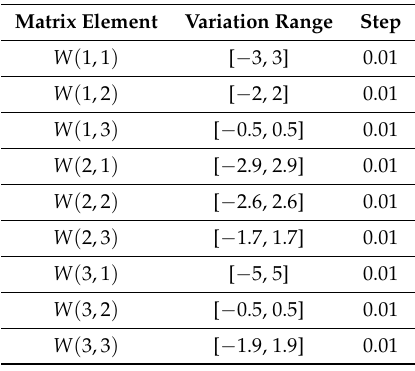
Table 1. Variation conditions of the elements in W .